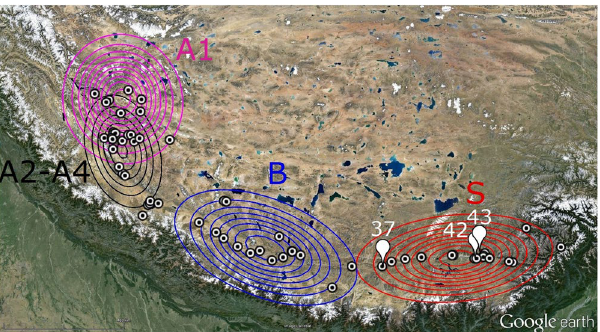
Figure 4. Bivariate normal contour plots showing the posterior distributions of the four phylogeographic clusters identified in P. theobaldi (A1, A2-A4, B and S) identified by BPEC, evaluated at the posterior means. Sample sites are given as circles, with the three inferred ancestral sites (37, 42, 43) also marked with a callout symbol. The background satellite map is from Google Earth (attribution: Image